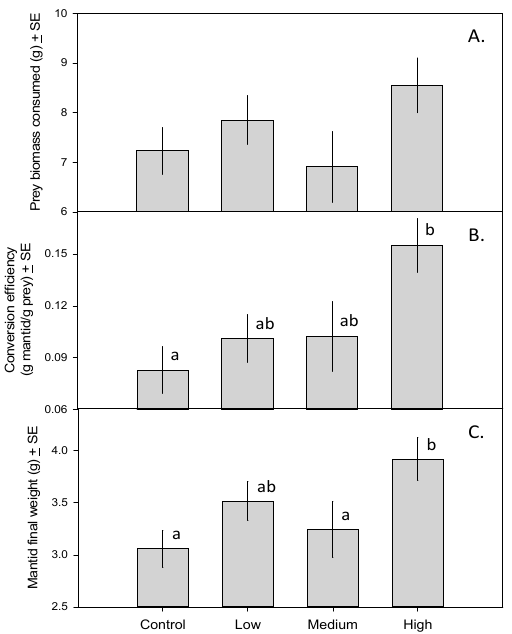
Figure 1. ( A ) Total prey biomass consumed by mantids fed zero, one, five, or 15 monarch caterpillars over a 35-day period ± SE; ( B ) Mantid trophic conversion efficiency (g mantid produced/g prey consumed) ± SE; ( C ) Final mantid weight (g) ± SE. Means with different letters are significantly